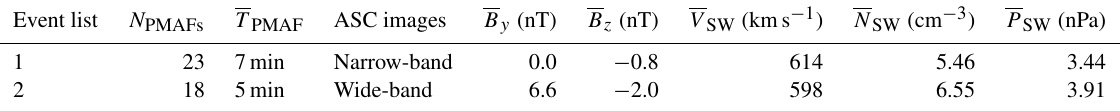
Table 1. Overview of both event lists showing the number of PMAFs N PMAFs , the average PMAF lifetime T PMAF , the presence of a narrow- band filter on the ASC, the average IMF components B y and B z and average values for solar wind speed V SW , plasma density N SW , and dynamic pressure P SW .